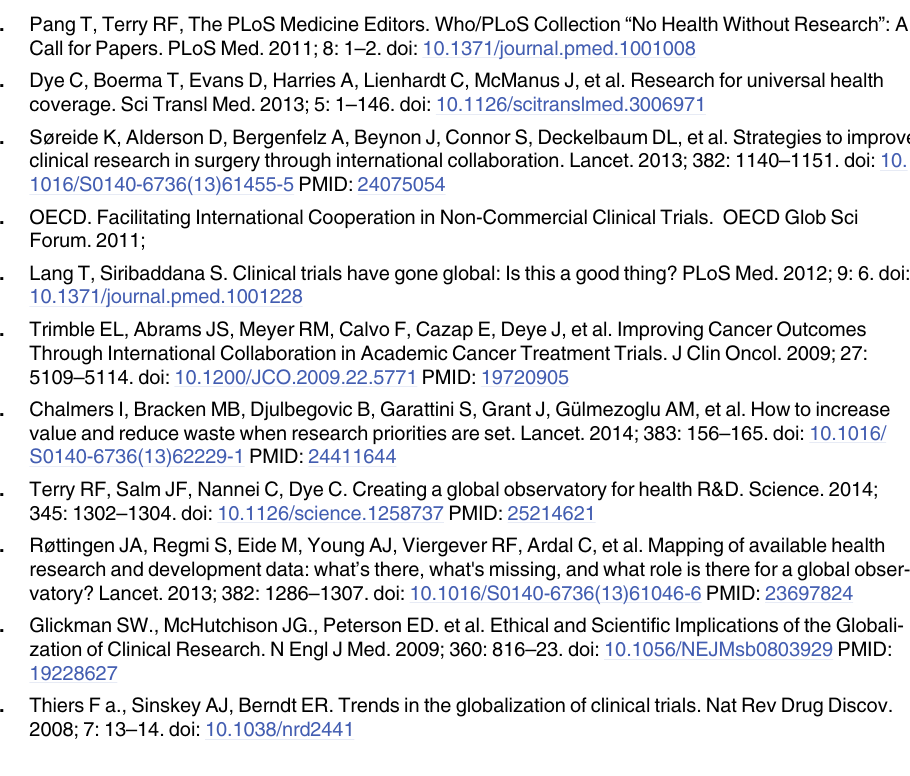
S7 Table. Distribution of country trial location of industry-sponsored trial over geographi- cal regions per year. S8 Table. Distribution of country trial location of non-industry-sponsored trial over geo- graphical regions per year. S9 Table. Distribution of country trial location of industry-sponsored trial over income groups per year. S10 Table. Distribution of country trial location of non-industry-sponsored trial over income groups per